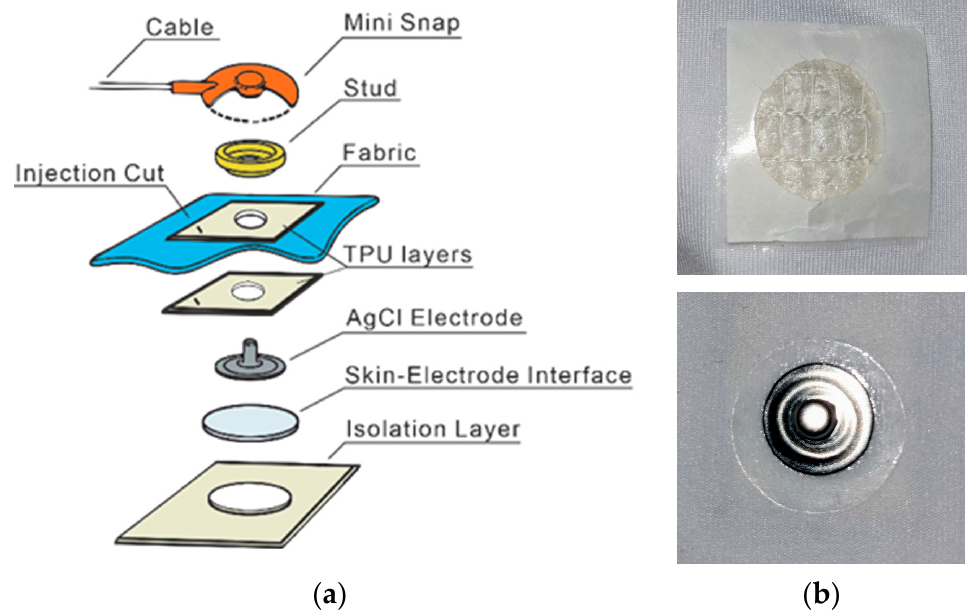
Figure 2. Schematic picture of the sensor element. ( a ) Components from the isolation layer to the stud are all pressed together to make up the entire sensor element in the cap. The isolation layer (TPU) faces the infant’s skin, the blue fabric depicts the cap textile, and the red button with cable is part of the bundle going to the amplifier. ( b ) Realistic sensor element prototype, including the snap electrode and skin–electrode interface sides.